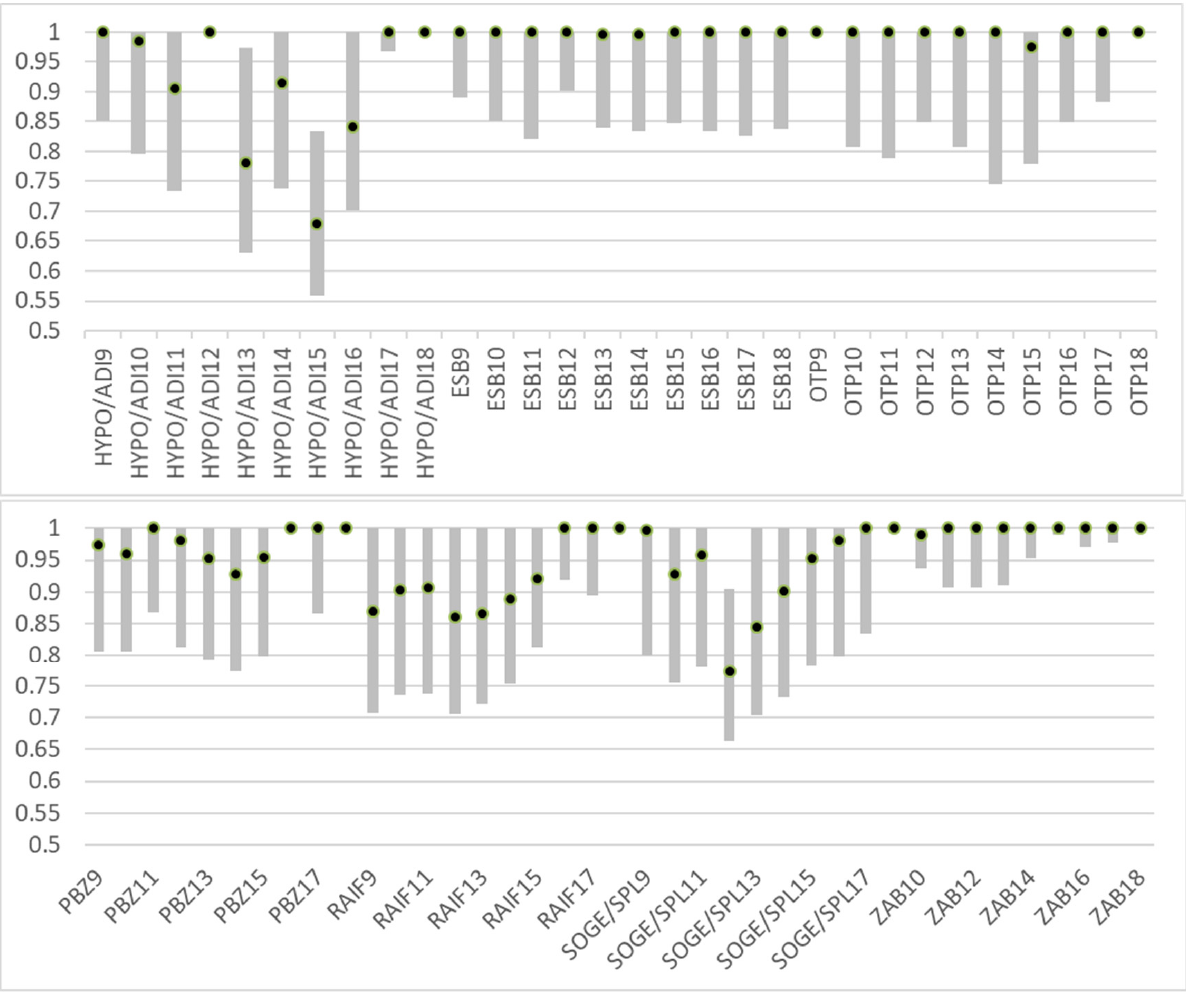
Figure 3. The efficiency score range for α = 0 and point values for α = 1.